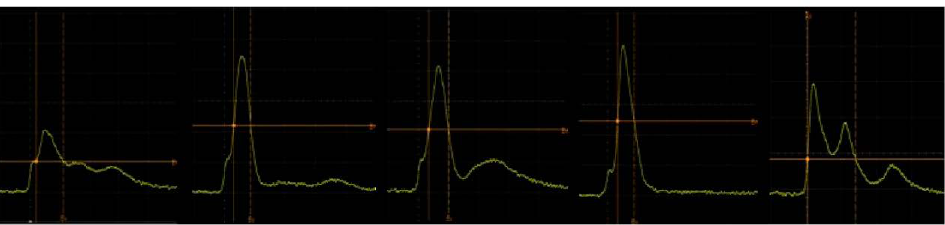
Figure 5. Series of Ti:Sapphire laser oscillograms, obtained without pump beam homogenization. Minimum duration of the main pulse is 930 ps. Reprinted with permission from ref. [18]. Copyright 2019 © The Optical Society.